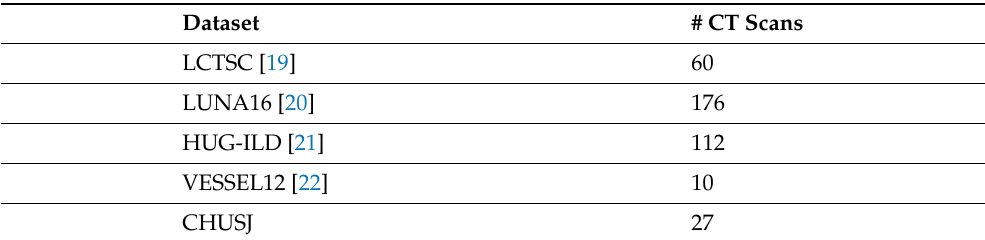
Table 1. Final number of patients with CT scans used from each